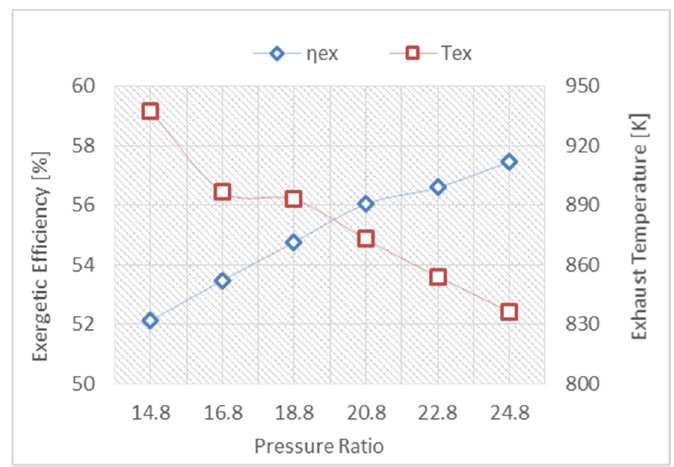
Figure 4. Exergetic efficiency and gas turbine exhaust gases temperature versus pressure ratios at ISO condition.